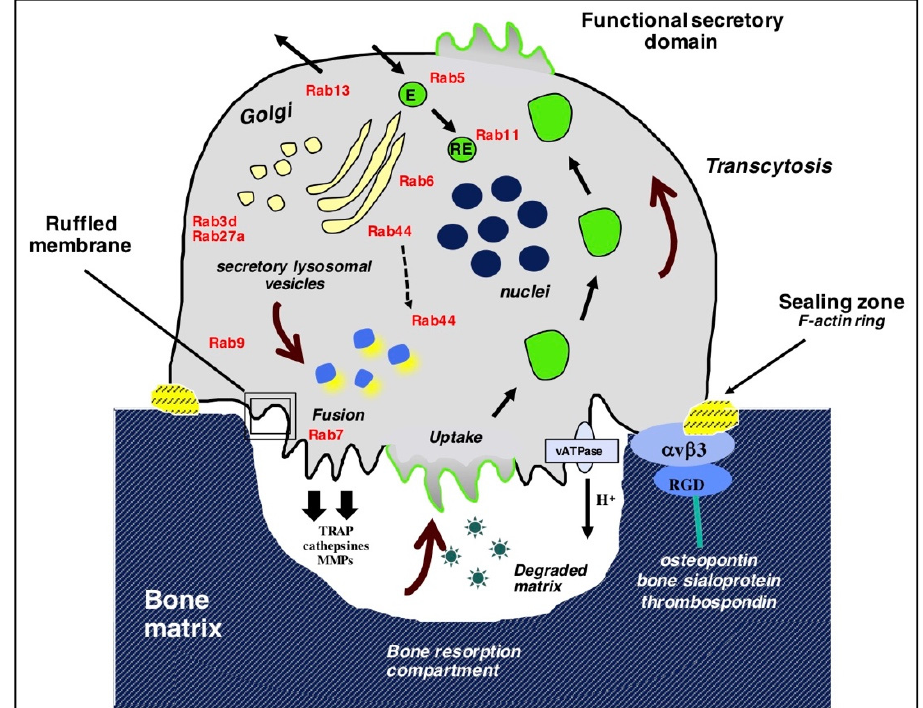
Figure 1. Bone resorption: a multi-step process involving vesicle trafficking . Osteoclasts polarize and reorganize their cytoskeleton upon adhering to the bone. The sealing zone (an actin-rich organelle-free zone) is formed by a peripheral belt of adhesive structures, which delimits the ruffled border, a highly specialized area consisting of membrane expansions directed toward the bone. The ruffled membrane is formed as a result of polarized vesicular trafficking and extensive fusion and plays a critical role in the degradation of bone matrix. Degraded bone matrix products are internalized at the uptake zone and transported by transcytosis toward the functional secretory domain. Several Rab proteins identified in osteoclasts have been added (in red). E: endosome; RE: recycling endosomes . Adapted from [8,13,14] .